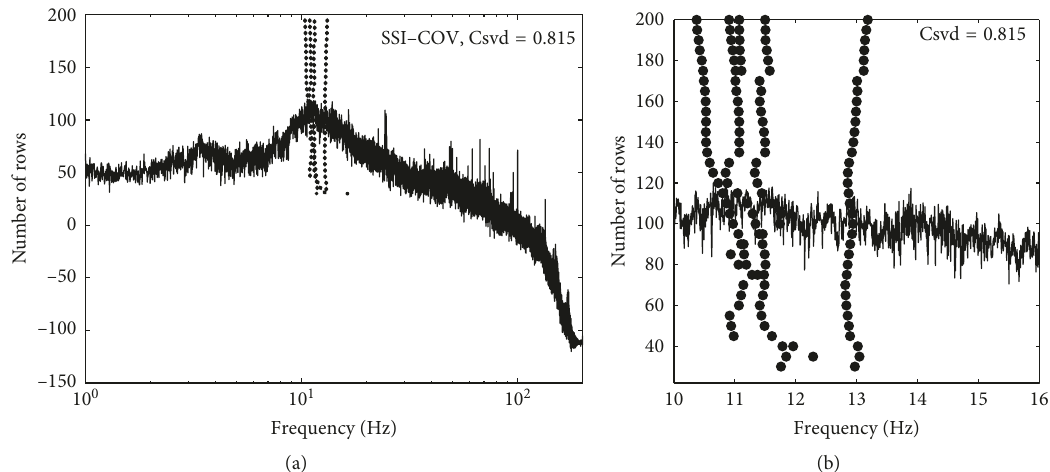
Figure 4: The stability diagram of the data collected at night by using the traditional SSICOV method.